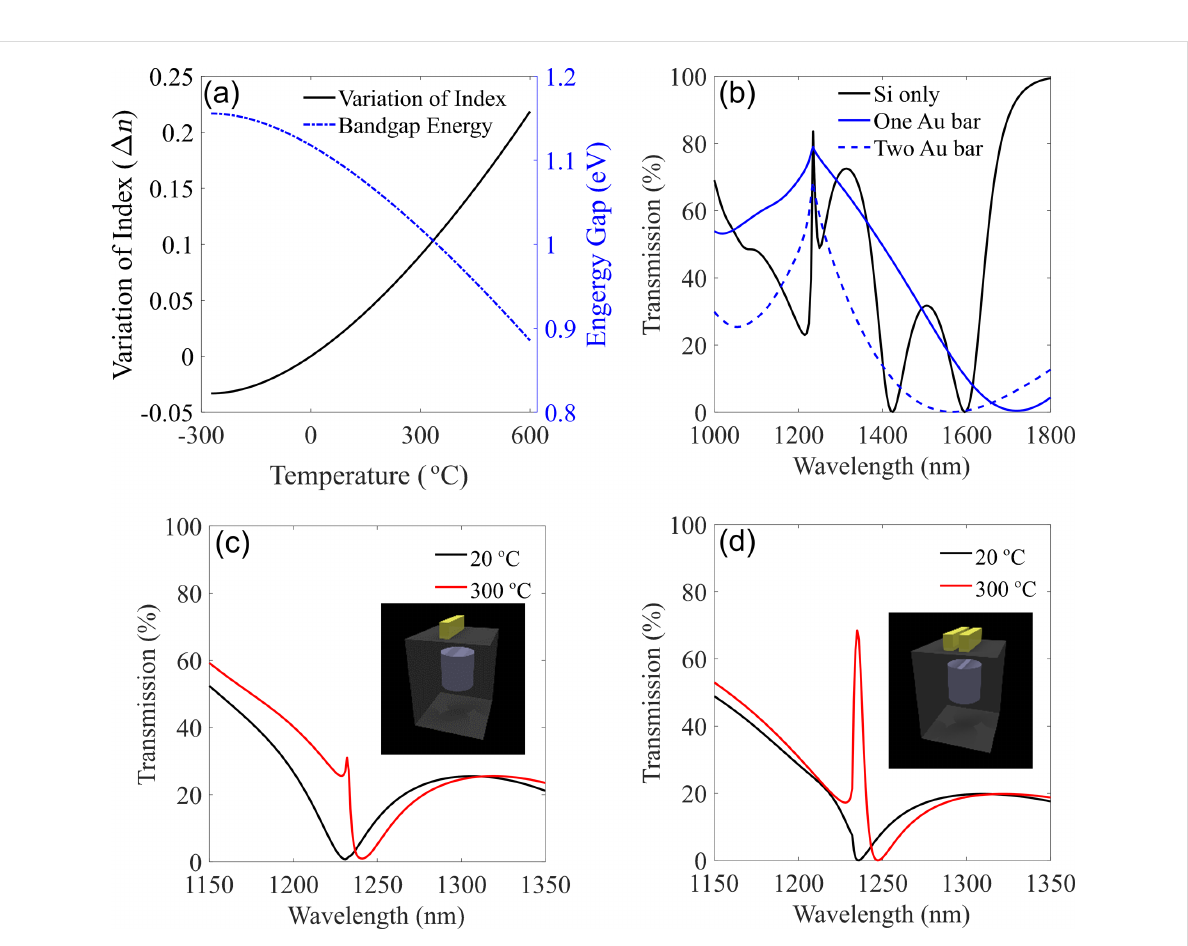
Figure 2: (a) Bandgap energy (blue curve) and variation of refractive index (dark curve) versus temperature change for bulk silicon [40]. (b) Transmis- sion of silicon only (black), one gold bar (red), and two gold bars (blue) in the wavelength range 1000 to 1800 nm at room temperature. (c) The trans- mission of the silicon with one gold bar at room temperature (20 °C) and 300 °C, respectively. (d) The transmission of the silicon with two gold bars at room temperature (20 °C) and 300 °C,